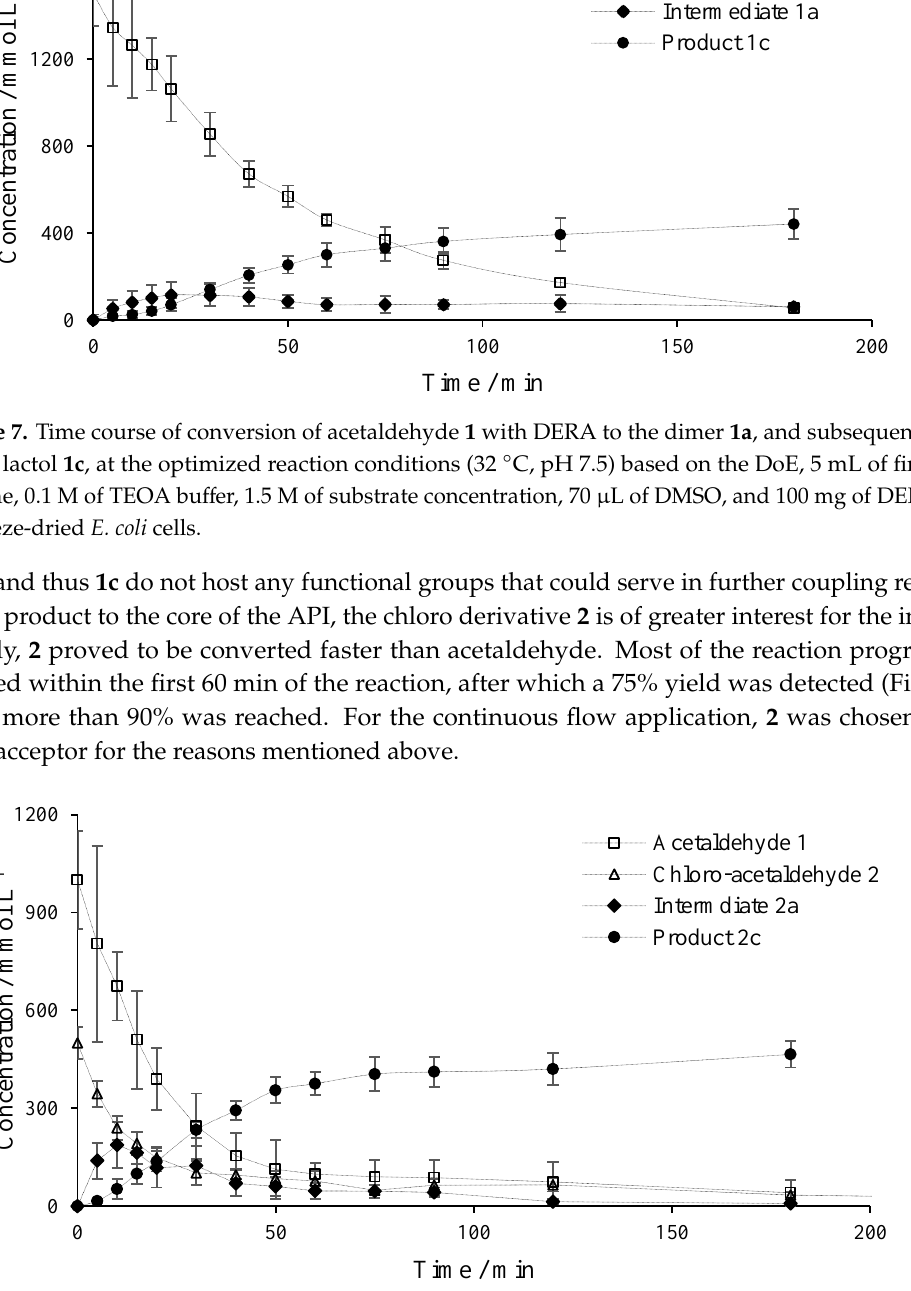
Figure 8. Time course of batch bioconversion of chloroacetaldehyde 2 (0.5 M) and acetaldehyde 1 (1.0 M) to the dimer 2a, and subsequently to the lactol 2c, at the optimized reaction conditions (32 °C, pH 7.5) based on the DoE, 5 mL of final volume, 0.1 M of TEOA buffer, 70 µL of DMSO, and 100 mg of DERA in freeze-dried E. coli cells.